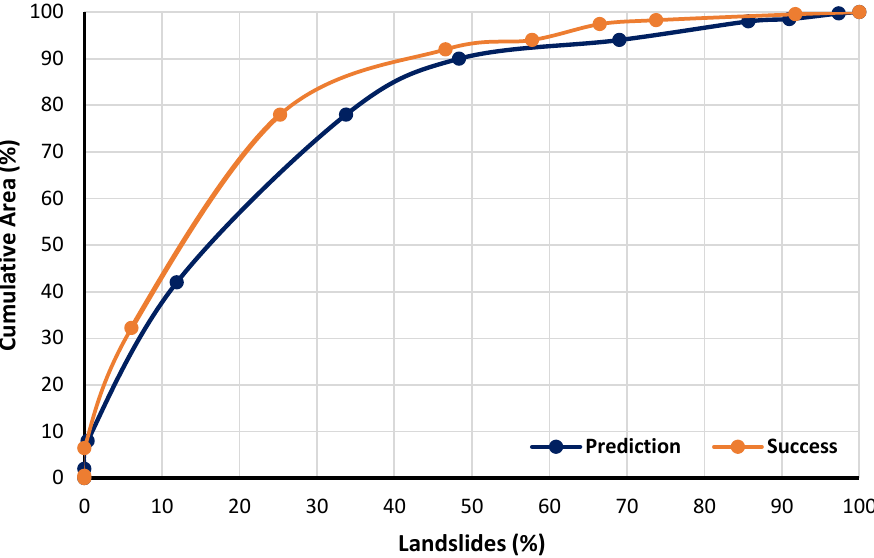
Figure 4. Prediction and Success Rate of the Logistic Regression Model using Area Under the Curve Method.